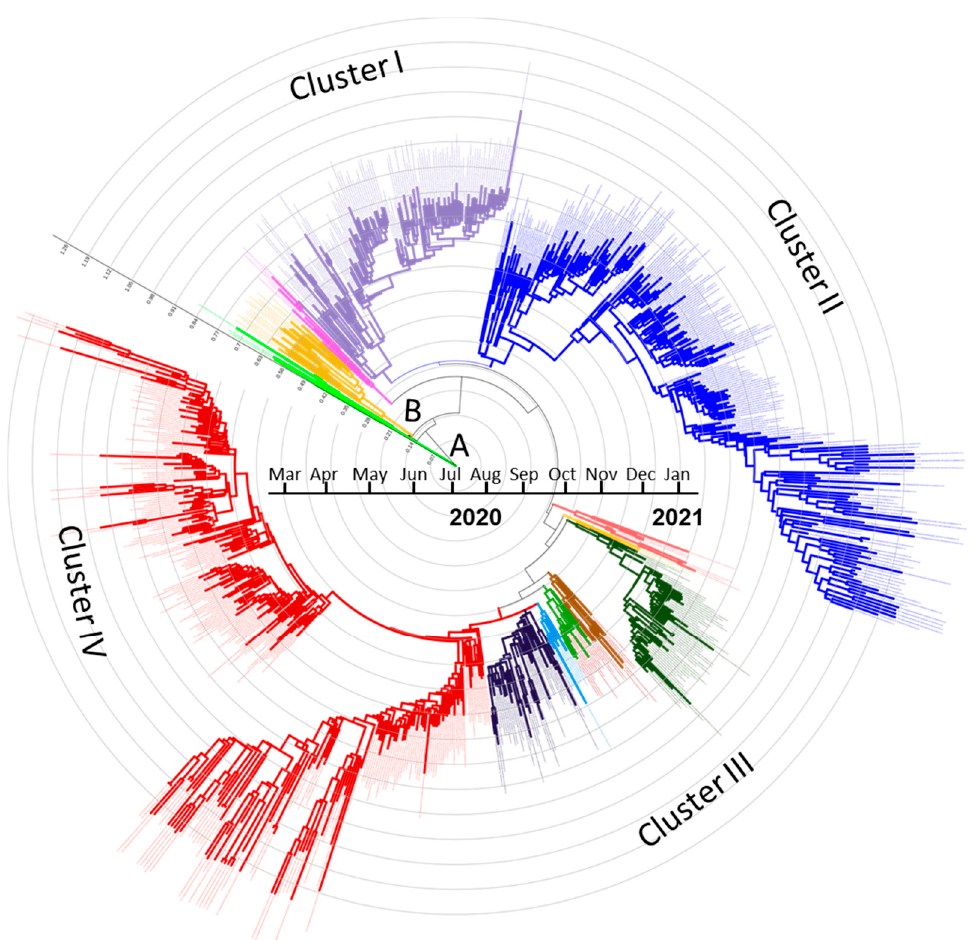
Figure 3. A time-scaled MCC tree indicating multiple clusters with many subdivisions (color separated). Viruses from March–September 2020 were incorporated in Cluster I, Cluster II, and Cluster III, whereas the viruses from October–December 2020 and January 2021 were assimilated into Cluster IV. All generated clusters belong to lineage B. Branch lengths were noted at the root of the tree. A and B indicate the origin of lineages A and B. The tree is rooted on Wuhan-Hu-1 (NC045512) reference strain. The full tree is available as Supplementary Figure S2.